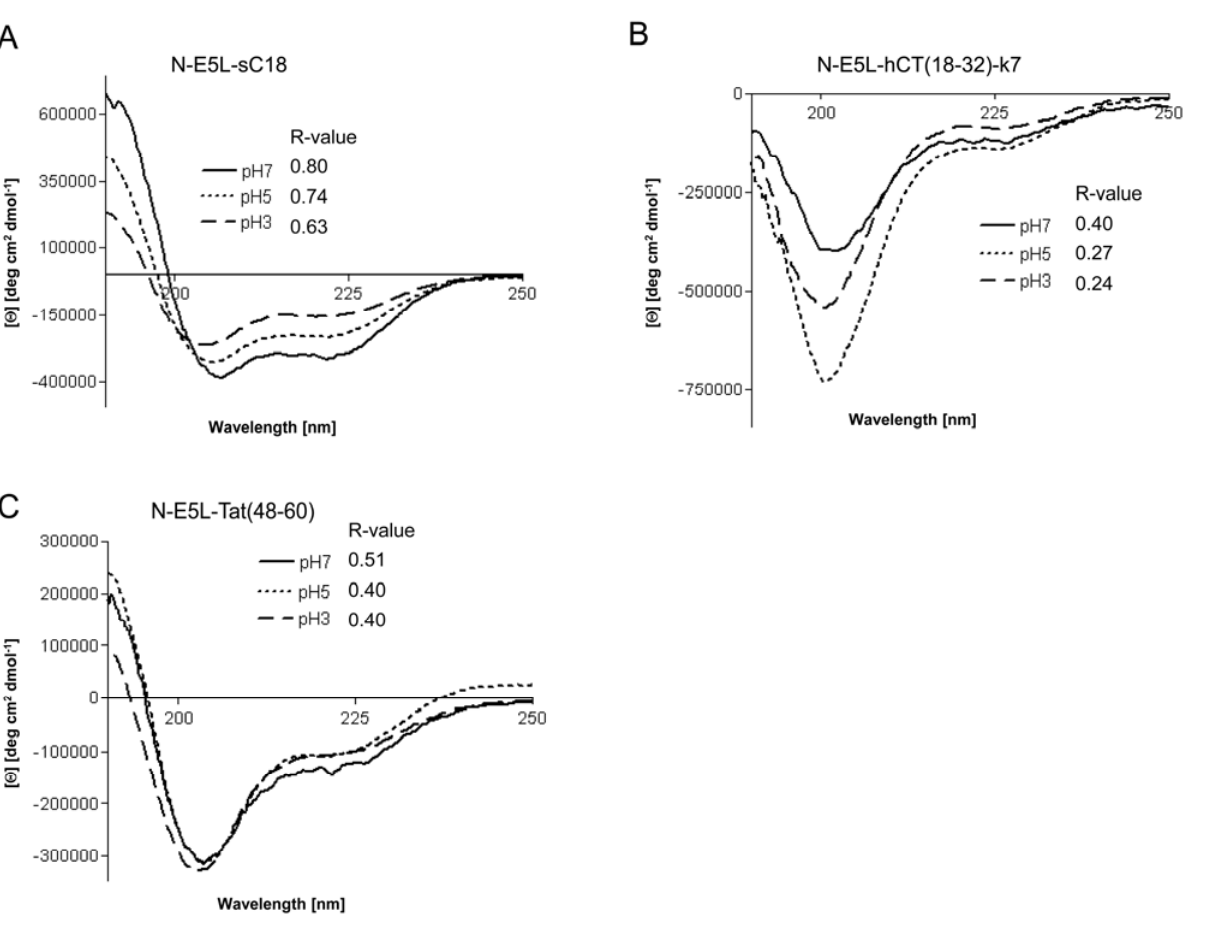
Figure 6. Circular dichroism spectra of N-E5L-sC18 (a), N-E5L-hCT(18-32)-7 (b) and N- E5L-Tat(48-60) (c) at different pH values. The spectra were measured at a peptide concentration of 20 µM in 10 mM phosphate buffer. R-values represent the ratios between the molar ellipticity values at 222 nm and 207